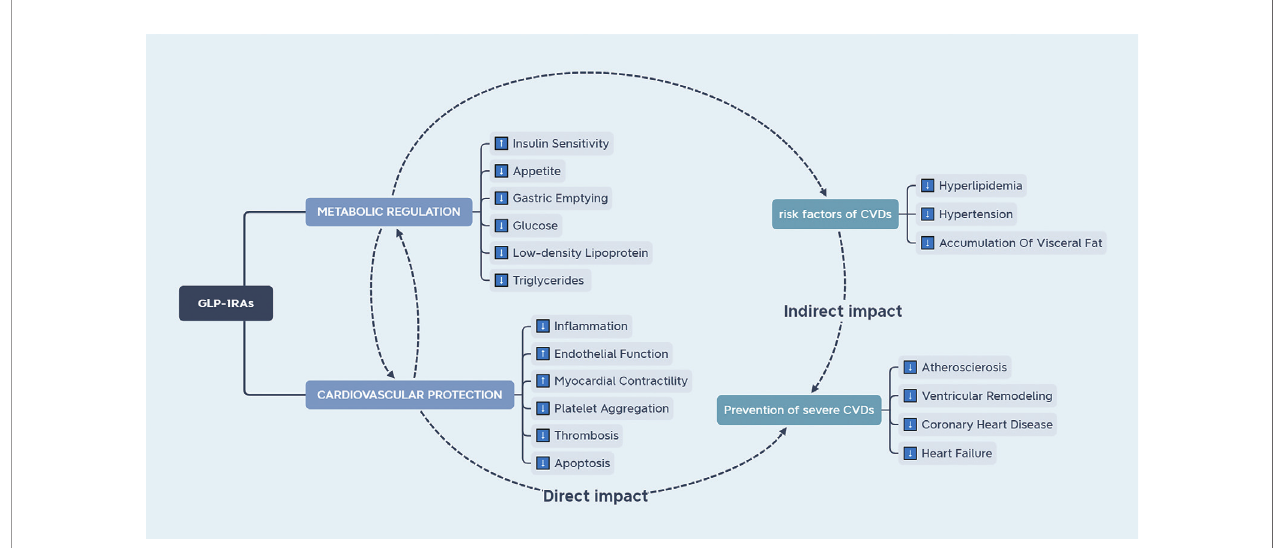
FIGURE 3 | The effect of GLP-1RAs on the cardiovascular system. GLP-1RAs have direct and indirect effects on the cardiovascular system. Endocrine factors can ameliorate the risk factors for cardiovascular